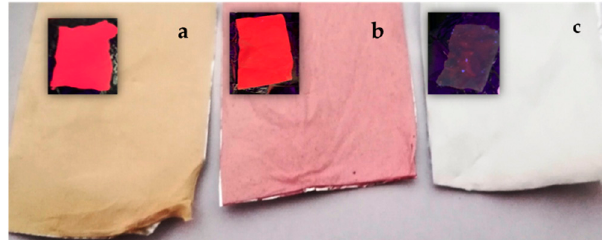
Figure 5. Pictures of ( a ) electrospun ZnTPP/PES, ( b ) electrospun H 2 TPP/PES, and ( c ) impregnated H 2 TPP/PES mats. Images under UV lamp irradiation are shown in the inset.